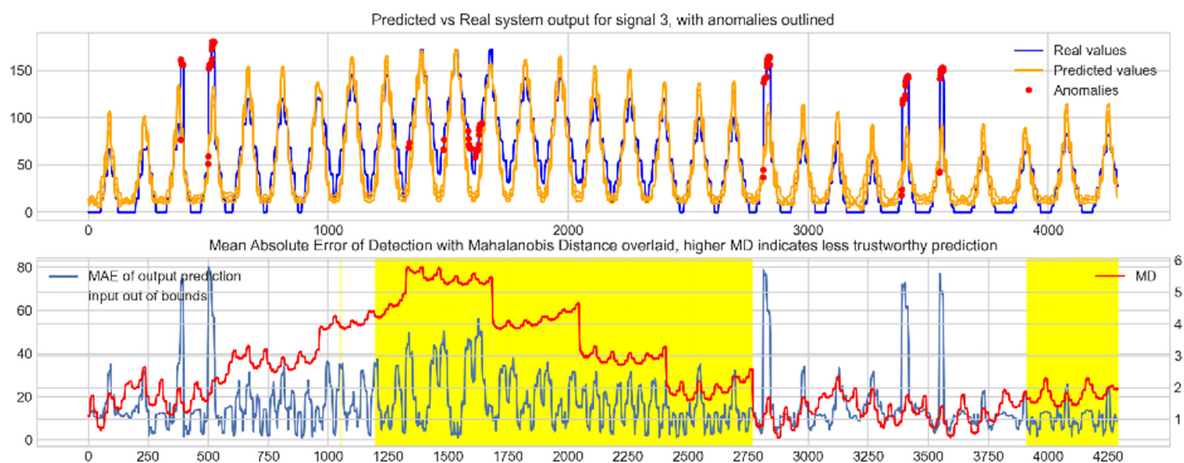
Figure 11. Predicted vs. real device output for signal 2, the left elevon, with anomalies labelled ( top ); MAE, MD and boundary check corresponding with the prediction ( bottom ). The yellow shaded areas represent new inputs outside expected input space.